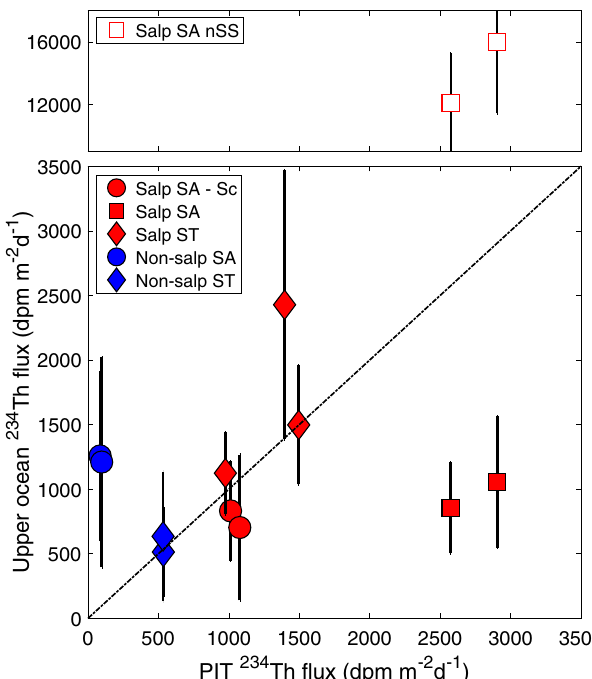
Fig. 6 | 234 Th fl ux out of the upper ocean. x axis indicates Th-234 fl ux estimates measured in PIT, while y axis indicates Th-234 fl ux estimates using the 238 U: 234 Th disequilibrium method, using water pro fi les of Th-234 and salinity-derived U- 238 estimates, with integration depths matching the depth of the Particle Inter- ceptor Traps (PIT). Filled markers indicate values estimated using steady-state assumptions, open markers (Salp Subantarctic, Salp SA) indicate non-steady state assumptions (box above break). Note scale change for the non-steady state. Error bars are 1 std propagated from all uncertainty terms.